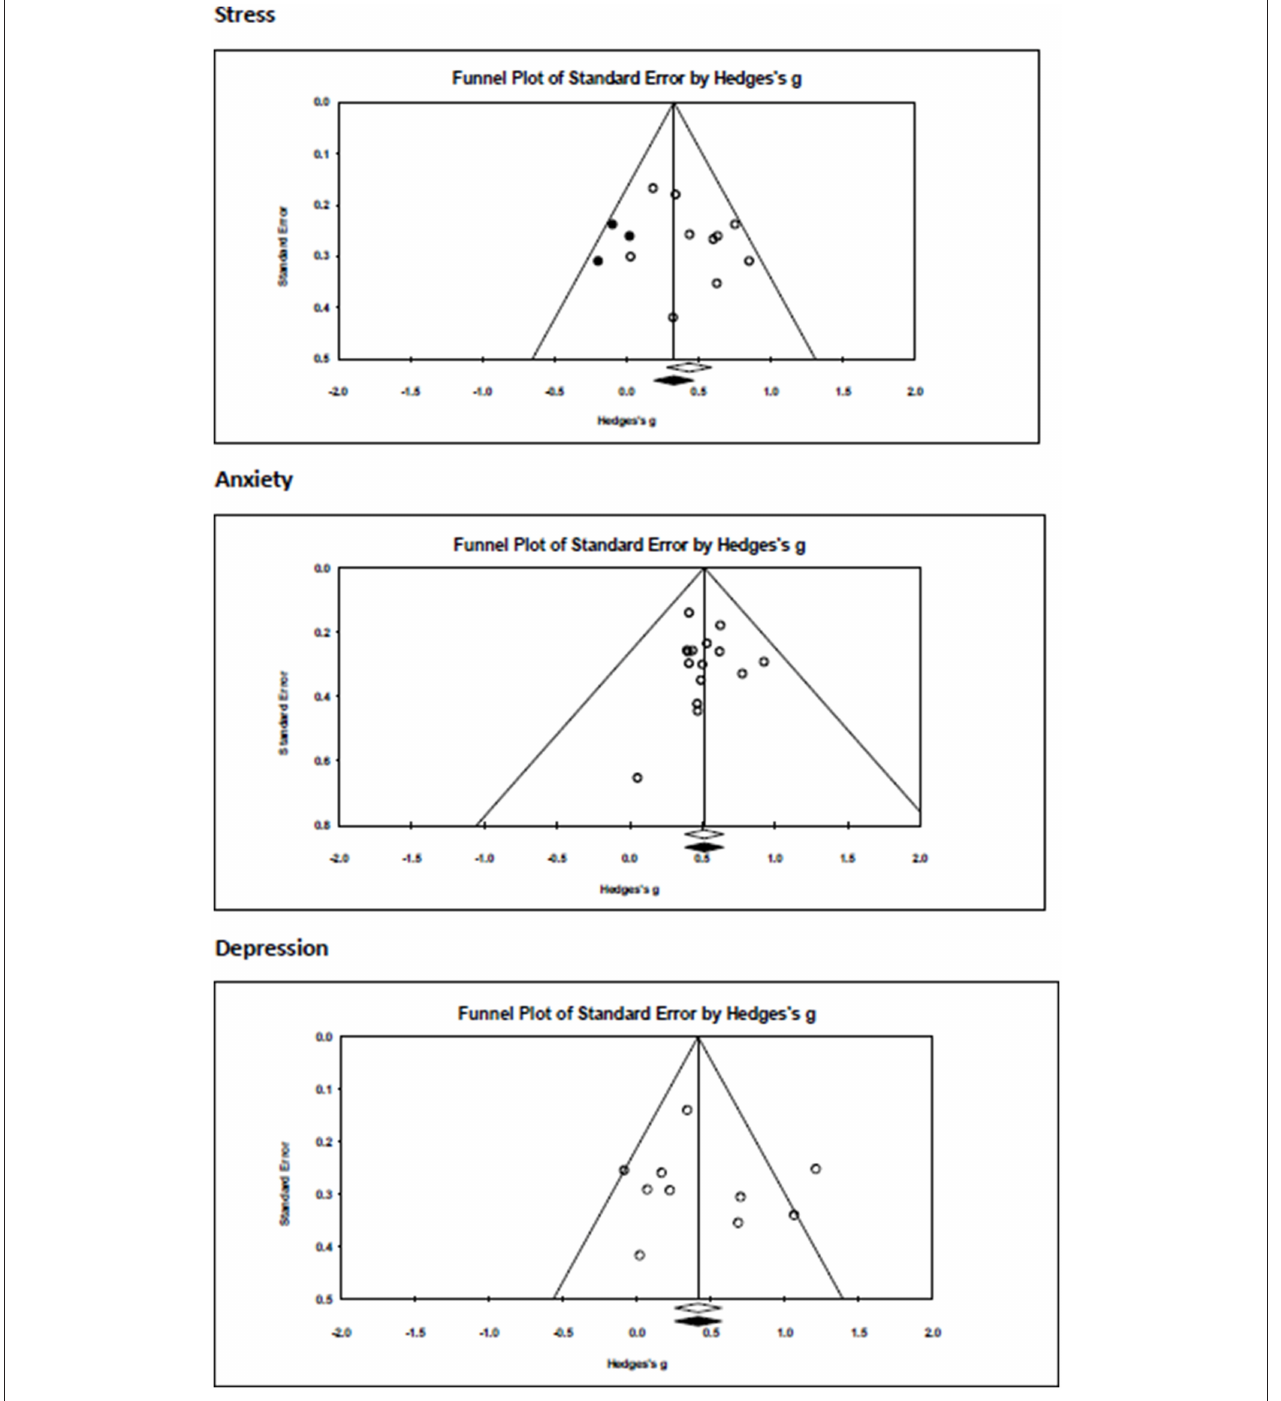
FIGURE 3 | Visual inspection of the funnel plots for stress, anxiety, and depressive symptoms. cover the same age range, inclusion criteria, similar outcomes and vs. similar